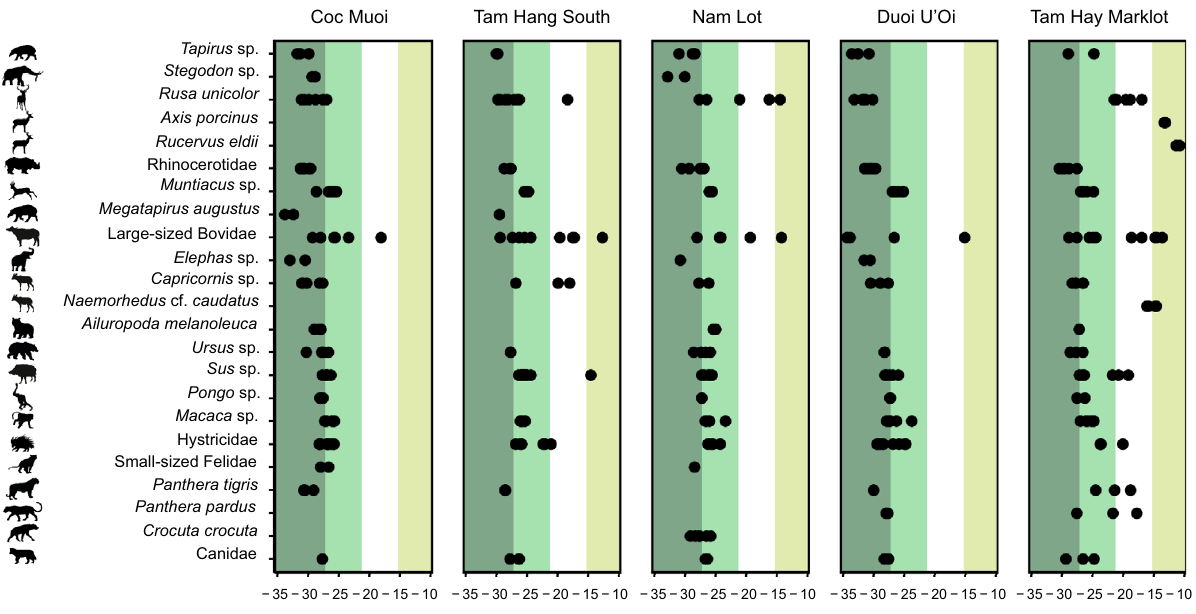
Figure 6. Comparison of range of δ 13 C values in selected taxa in the five faunas, following a chronological sequence from the oldest (left) to the youngest (right). Shaded areas represent δ 13 C carbon source values associated with closed-canopy forests ( ■ δ 13 C carbon source < − 27.2 ‰), intermediate rainforests and woodland biomes ( ■ δ 13 C carbon source > − 27.2 ‰ and < − 21.3 ‰); and savannah-like environments ( ■ δ 13 C carbon source > − 15.3 ‰). The white area ( δ 13 C carbon source > − 21.3 ‰ and < − 15.3 ‰) consists in values resulting from the combined consumption of both C 3 and C 4 resources, and does not correspond to any specific ecological